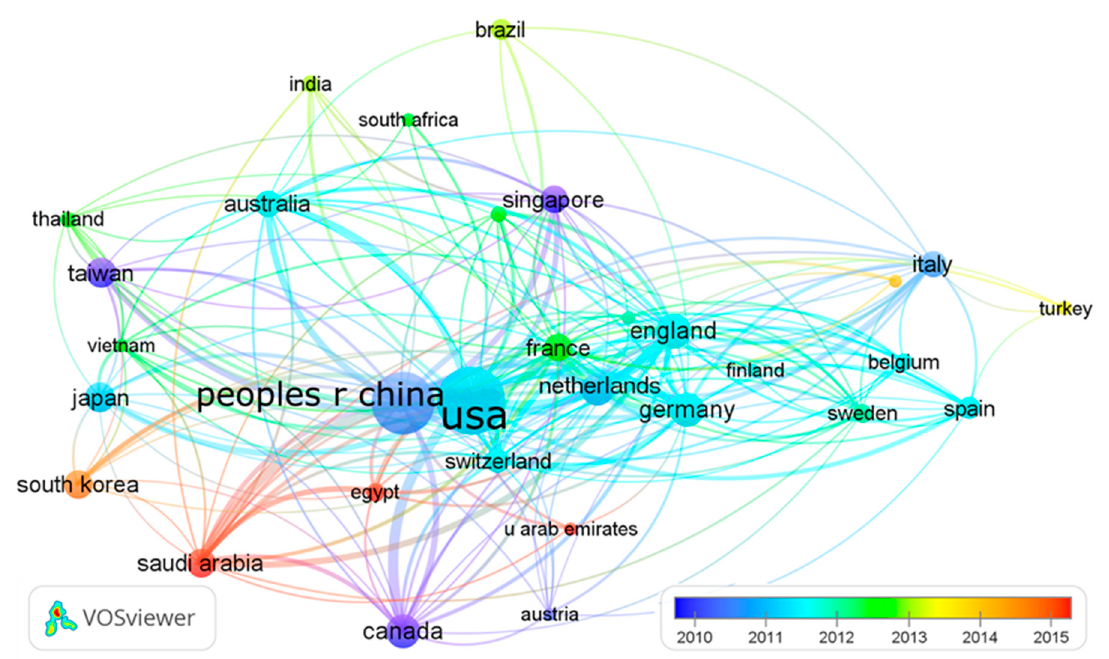
Figure 6. Collaboration network of countries.